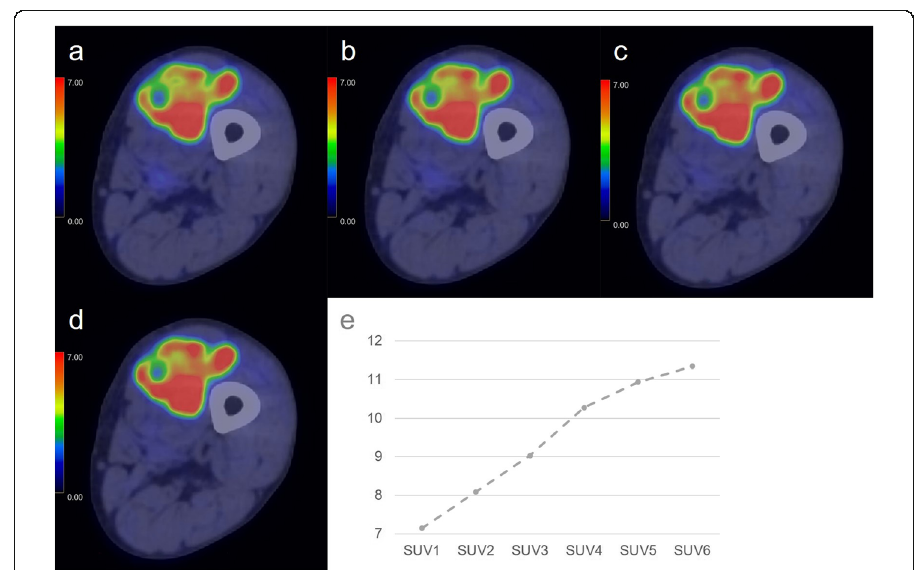
Fig. 4 A 78-year-old woman with metastatic soft tissue tumour from gastric cancer in the left thigh. Dynamic positron-emission tomography/computed tomography (PET/CT) ( a – d ) images are shown. In all dynamic phases ( a – d ), the soft tissue tumour is avid for methionine (MET). The inhomogeneous and intense MET accumulation in soft tissue tumours is identifiable from the dynamic first phase (SUVmax: dynamic first phase ( a ), 7.15; dynamic second phase ( b ), 8.09; dynamic third phase, 9.03; dynamic fourth phase ( c ), 10.28; dynamic fifth phase, 10.94; dynamic sixth phase ( d ), 11.34). The accumulation gradually becomes more intense in most parts of the tumour during the dynamic phases ( a – d ). The time-SUVmax curve ( e ) shows a high level in SUVmax at the dynamic first phase and a continuous increase during the dynamic phases